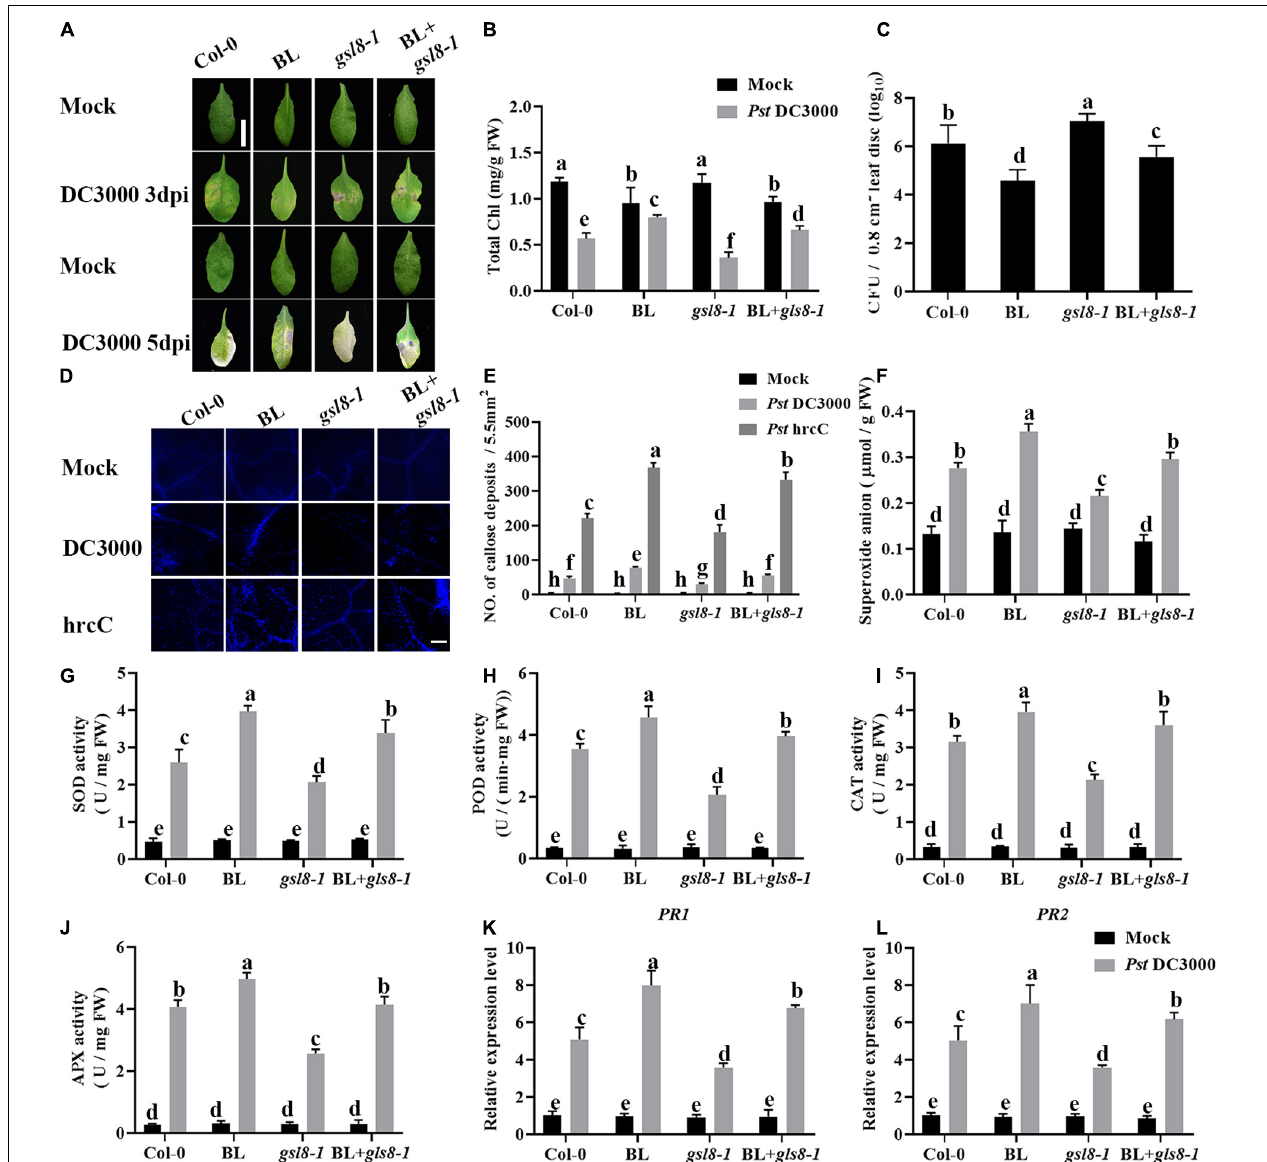
FIGURE 10 | Brassinosteroid-induced disease resistance partially depends on GSL8 . (A) Typical Pst DC3000 infection symptoms in Col-0, BL, gsl8-1 , and BL + gsl8-1. Pictures were taken at 3 and 5 dpi, respectively. Bar, 1.00 cm. (B) Total chlorophyll content in inoculated leaves was detected in planta at 3 dpi. (C) Bacterial growth in the inoculated leaves was detected in planta. Bacteria were isolated from plants at 1 dpi and quantified with gradient dilution assays. (D) Callose deposition in infected leaves at 1 dpi. Callose deposition was visualized by fluorescence microscopy. Bar, 200 µ m. (E) Number of callose deposition in the 5.5 mm 2 microscopic fields. Callose deposition was counted in 8–12 microscopic fields of 5.5 mm 2 from 8 to 12 different leaves and three biological repeats. (F) The superoxide content in the infected leaves at 1 dpi. The activities of the antioxidant enzymes SOD (G) , POD (H) , CAT (I) , and APX (J) . (K,L) Relative expression levels of defense-related genes PR1 and PR2. Data presented are mean ± SD from three independent experiments. The expression of ACTIN2 was used as an internal reference. Significant differences ( P < 0.05) are denoted by different lowercase